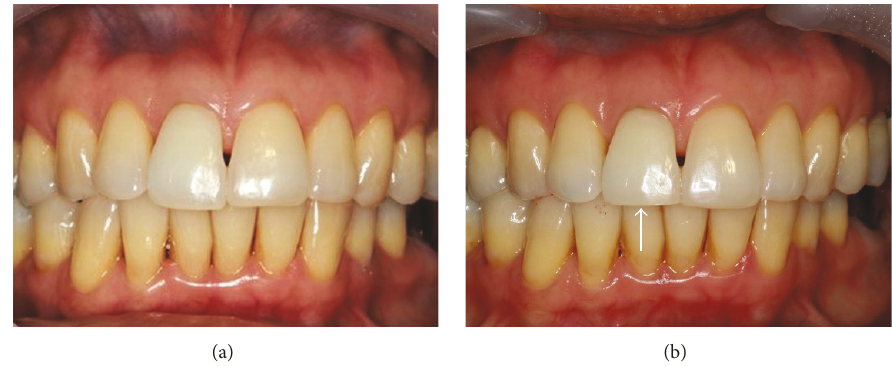
Figure 3: (a) Intraoral photograph after three cycles of internal bleaching of tooth 11 (July 2013) shows that the color was brighter than that of adjacent teeth (b) The incisal edge of tooth 11 was slightly reduced to minimize loading (arrow) (June 2015). The color of tooth 11 has not changed when compared with the tooth color immediately after MTA obturation and intracoronal bleaching performed two years